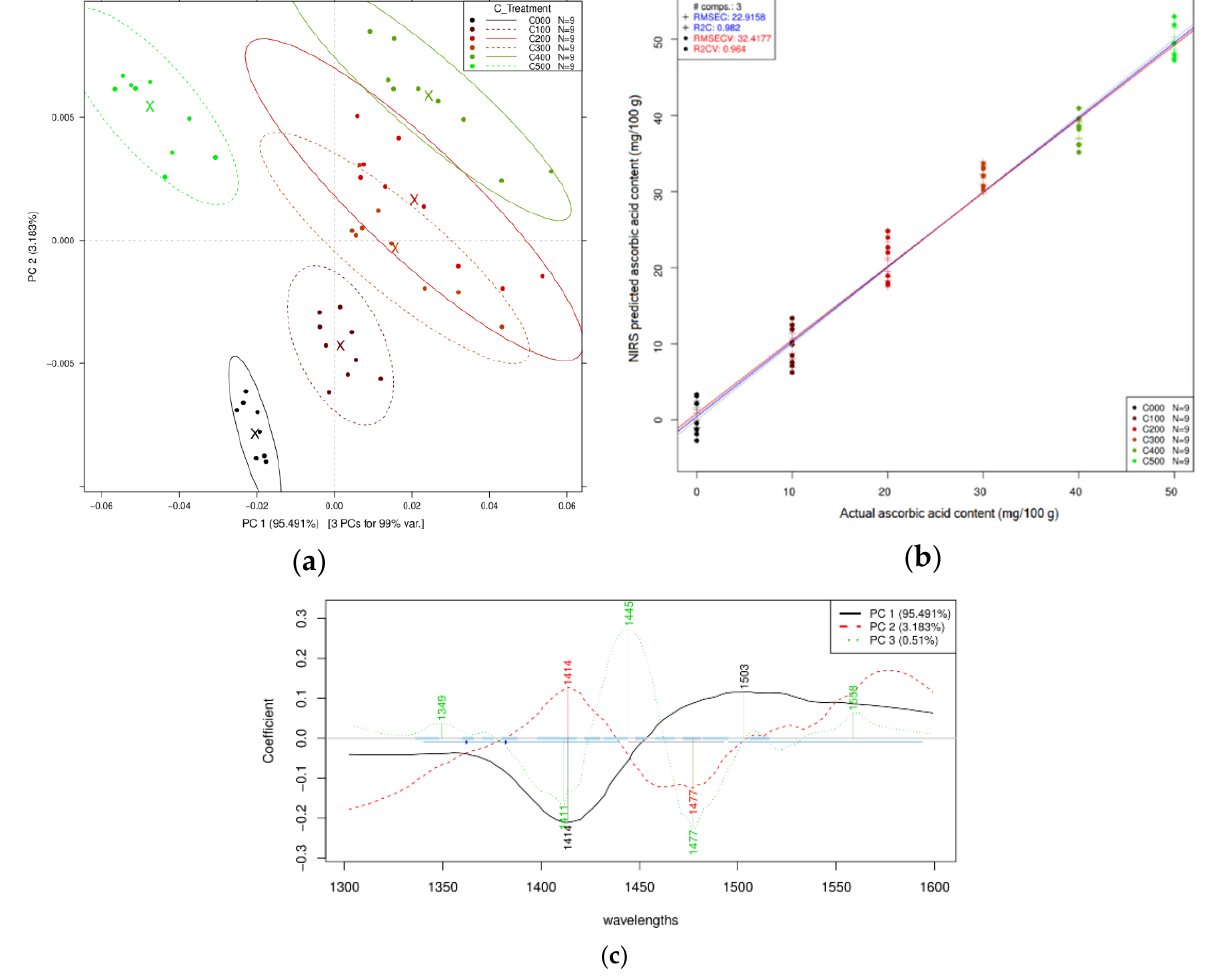
Figure 6. Multivariate analysis from the ascorbic acid spectral data after SG and SNV pretreatment: ( a ) PCA plot of ascorbic acid within 1300–1600 nm wavelength, ( b ) PLSR plot of ascorbic acid after 6-fold cross-validation, and ( c ) PCs loading plot of ascorbic acid.